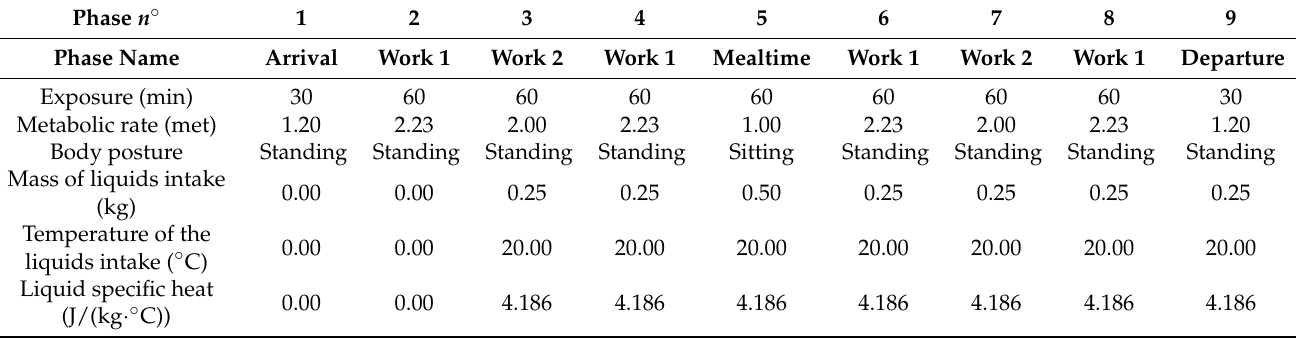
Table 1. Characteristics of the nine phases of the working day for working profiles G_12 and G_14.